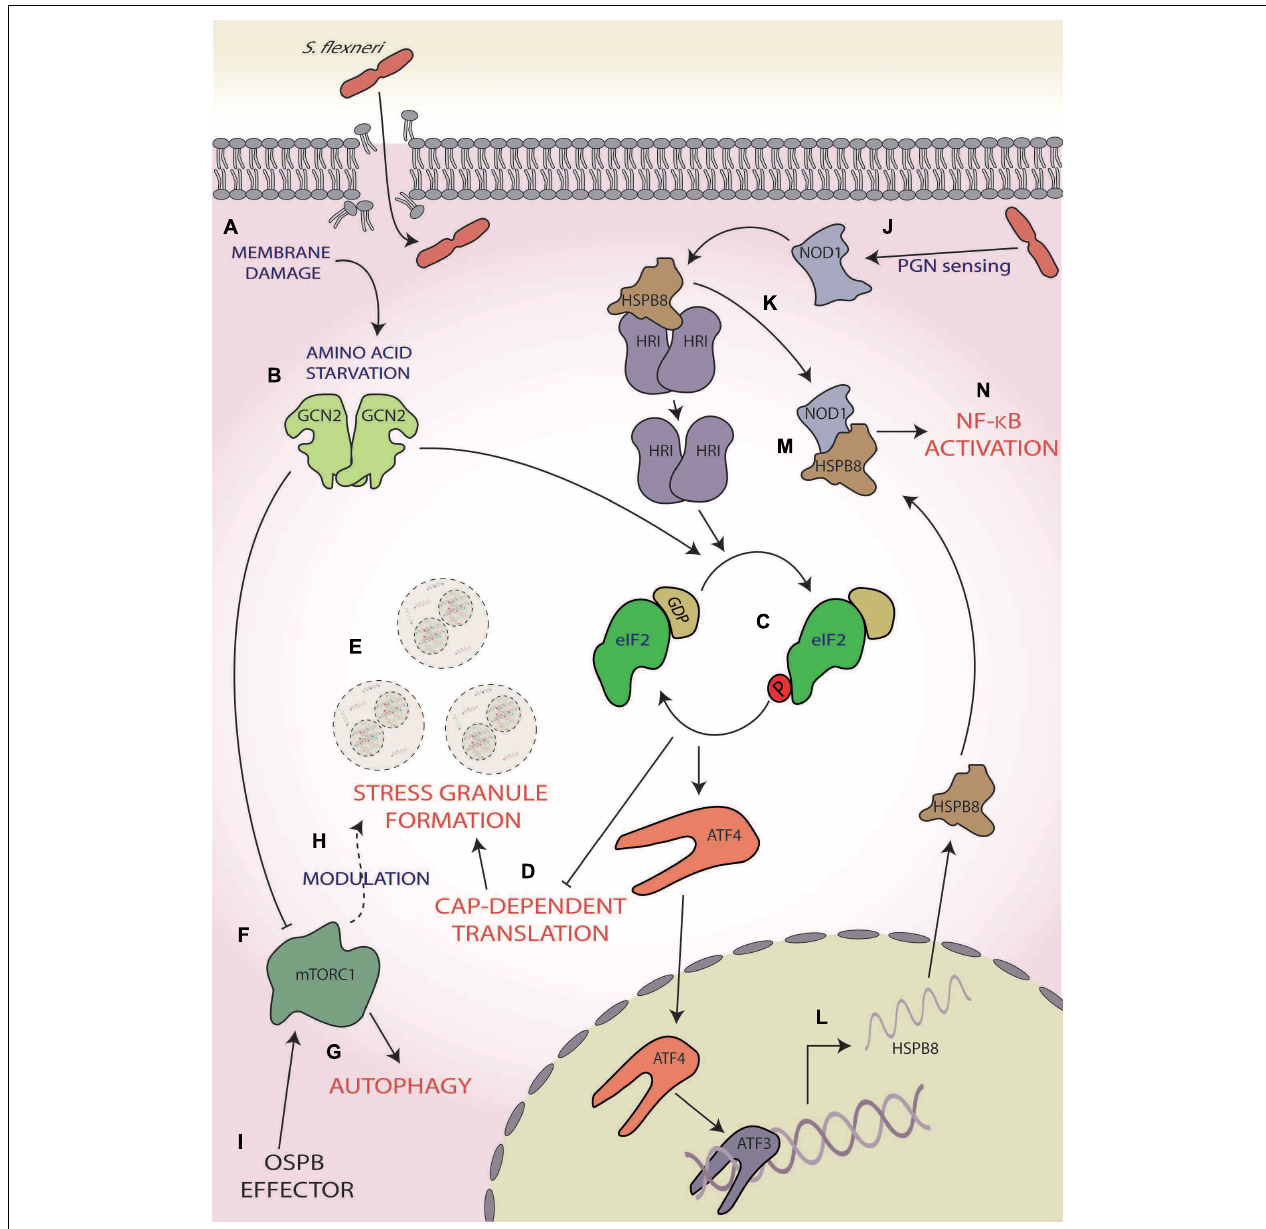
FIGURE 3 | Shigella flexneri. (A) Membrane damage caused during S. flexneri internalisation induces amino acid (AA) starvation, (B) activating general control non-depressible 2 (GCN2), and (C) subsequently phosphorylation of eIF2 α . (D) This results in the inhibition of cap-dependent translation initiation (E) and consequently the formation of stress granules. (F) GCN2 also inhibits mammalian target of rapamycin complex 1 [mTORC1; (G) ], inducing autophagy and (H) modulating the frequency and composition of stress granules during exogenous stress induction. (I) mTORC1 activity is reactivated during later-stage infection via S. flexneri’s OspB effector. (J) Concurrently, S. flexneri ’s peptidoglycan is detected by nucleotide-binding oligomerisation domain-containing protein 1 (NOD1), (K) which induces dissociation of the chaperone heat shock protein beta-r 8 (HSPB8) from HRI, causing its activation and subsequent eIF2 α phosphorylation. (L) This results in the activation of activating transcription factor 4 (ATF4), which along with ATF3, upregulated the expression and translation of HSPB8. (M) This nascent HSPB8 associates with NOD1 (N) leading to the activation of pro-inflammatory responses by nuclear factor kappa-light chain-enhancer of activated B cell (NF- κ B)